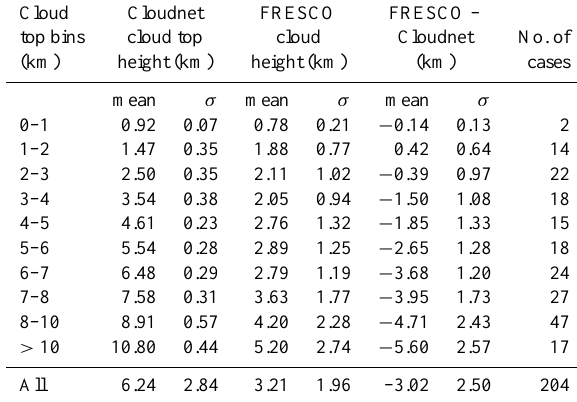
Table A5. Comparison of SCIAMACHY FRESCO cloud height with Cloudnet cloud top height for multilayer